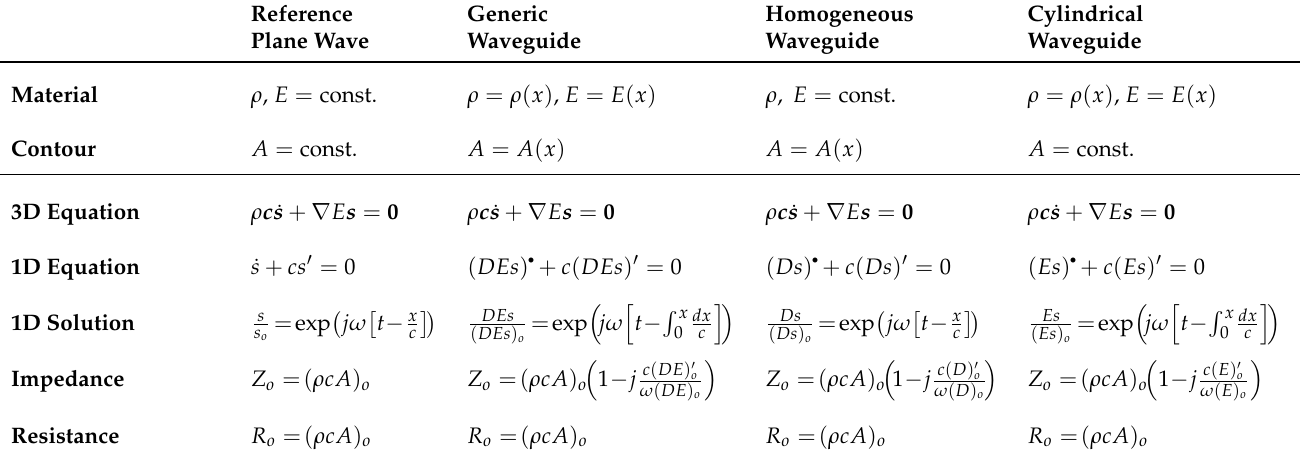
Table 1. Overview: 1D one-way wave equations, solutions; generic case and different